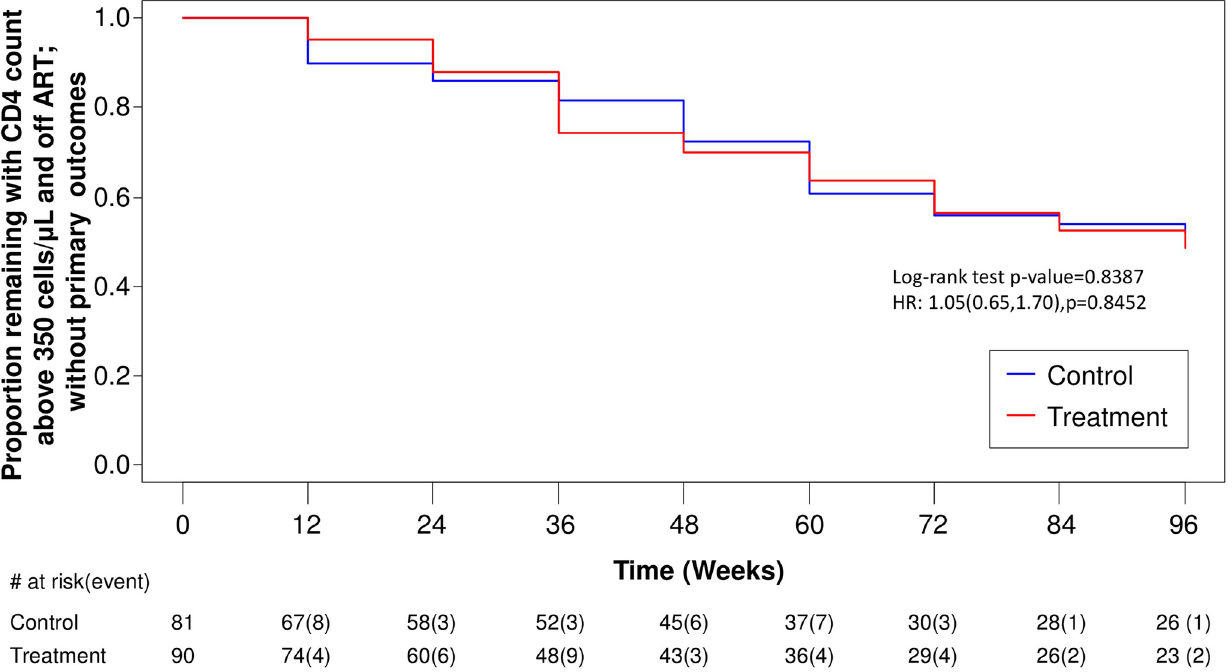
Fig 4. Kaplan-Meier Curve: Time to any primary outcome event. Week 0 includes all individuals who were screened in allocated to a group (CD4 < 350, ART, AIDS or death). The table beneath shows the individuals remaining at risk at each time point and the number of individuals experiencing an event at that time point is in brackets. There were 32 events in the Control group and 34 events in the Treatment group over the study period of 96 weeks.